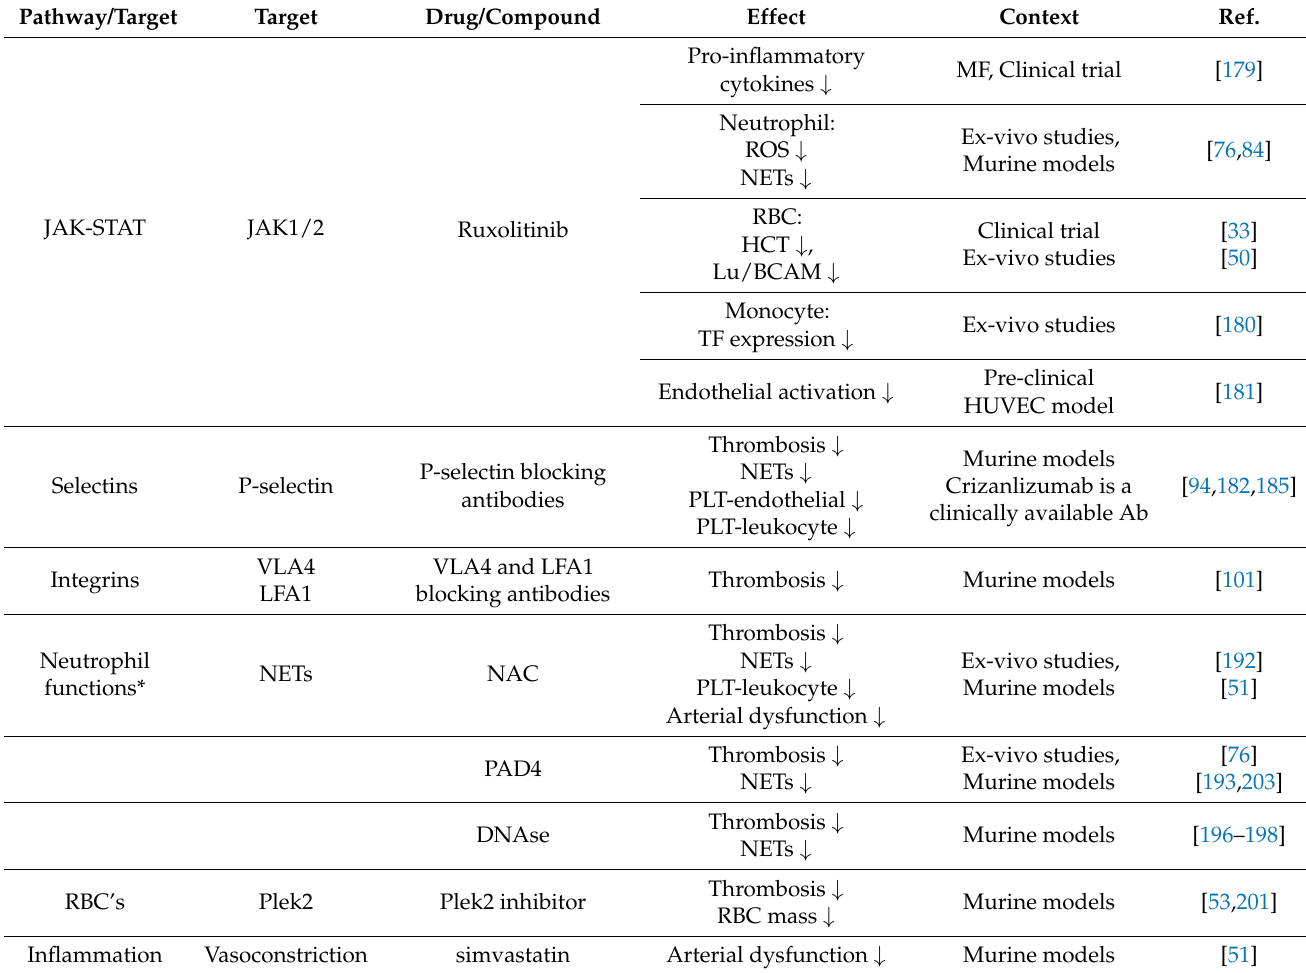
Table 1. Potential novel approaches to target pro-thrombotic pathways in